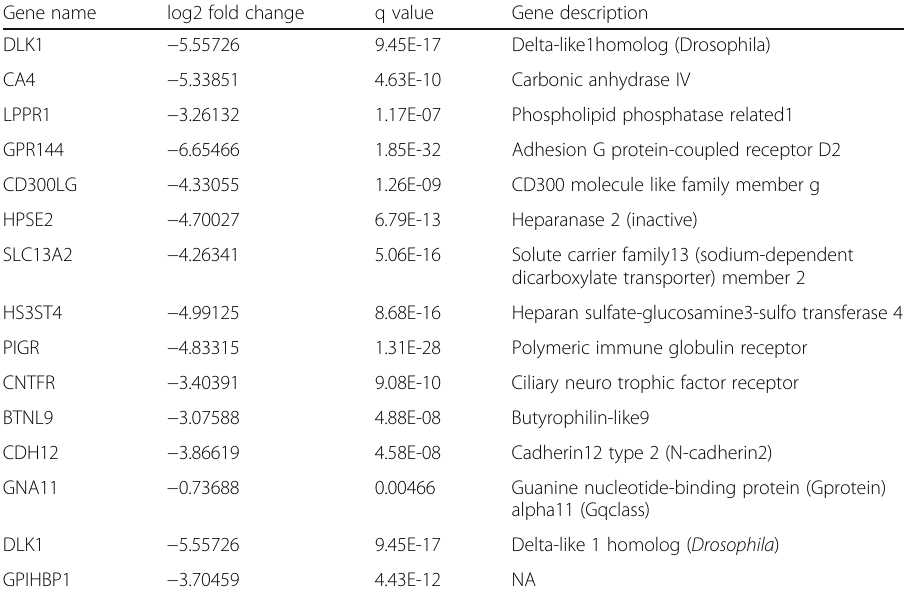
Table 5 Downregulated genes in breast cancer